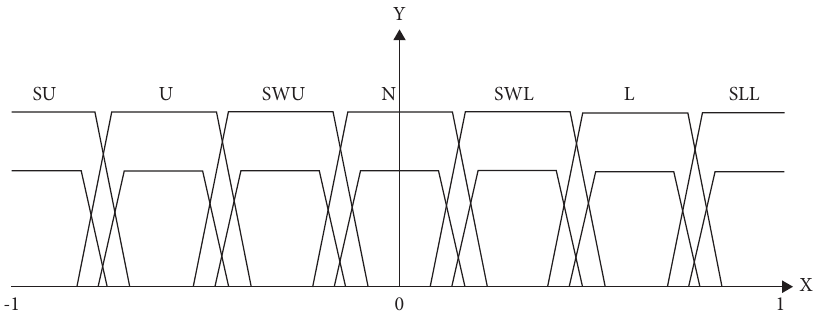
Figure 3: Te positive and negative reliability for the extended